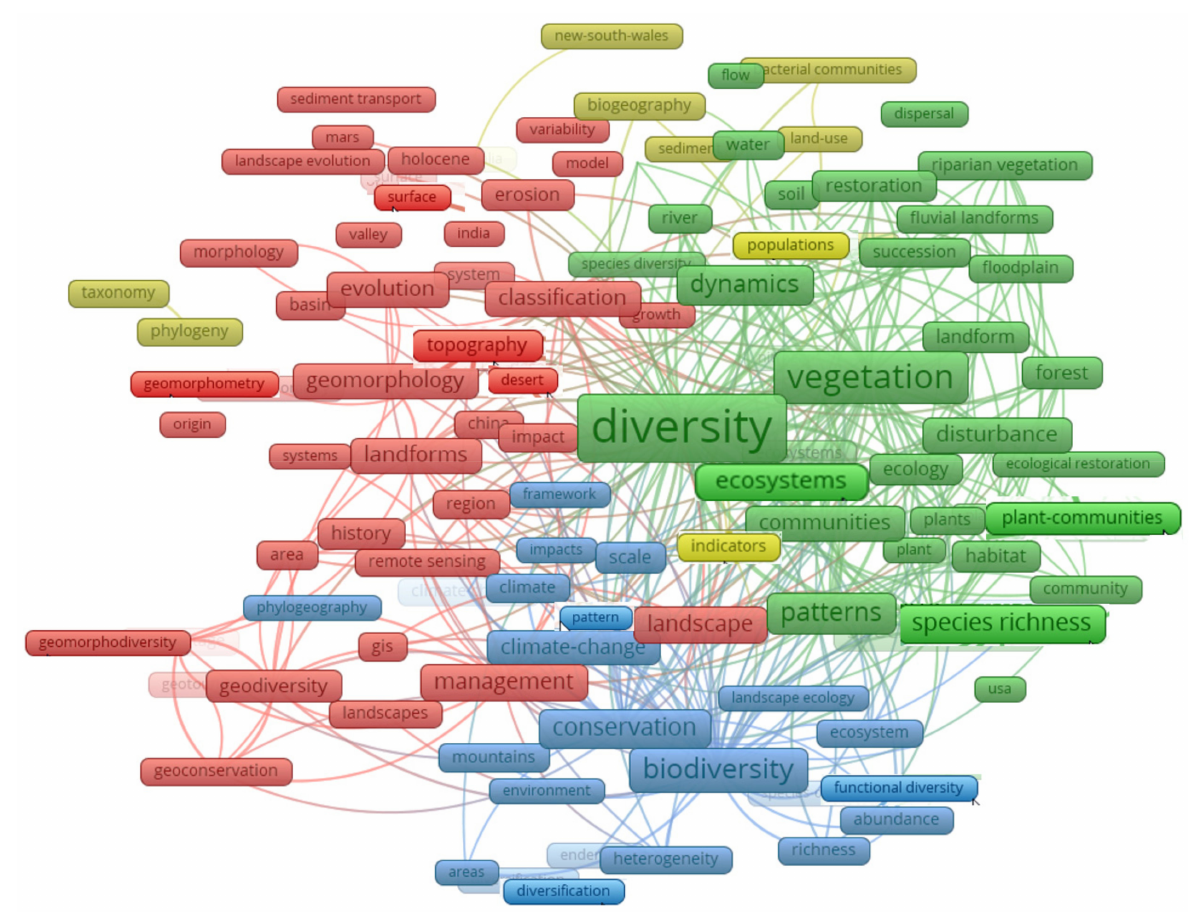
Figure 19. Keywords and their co-occurrence in a bibliographic search in the Web of Science, with the topics: “geomorphodiversity” or “geomorphological diversity” or “landform diversity”; date of analysis, April 2022, finding 653 papers and around 100